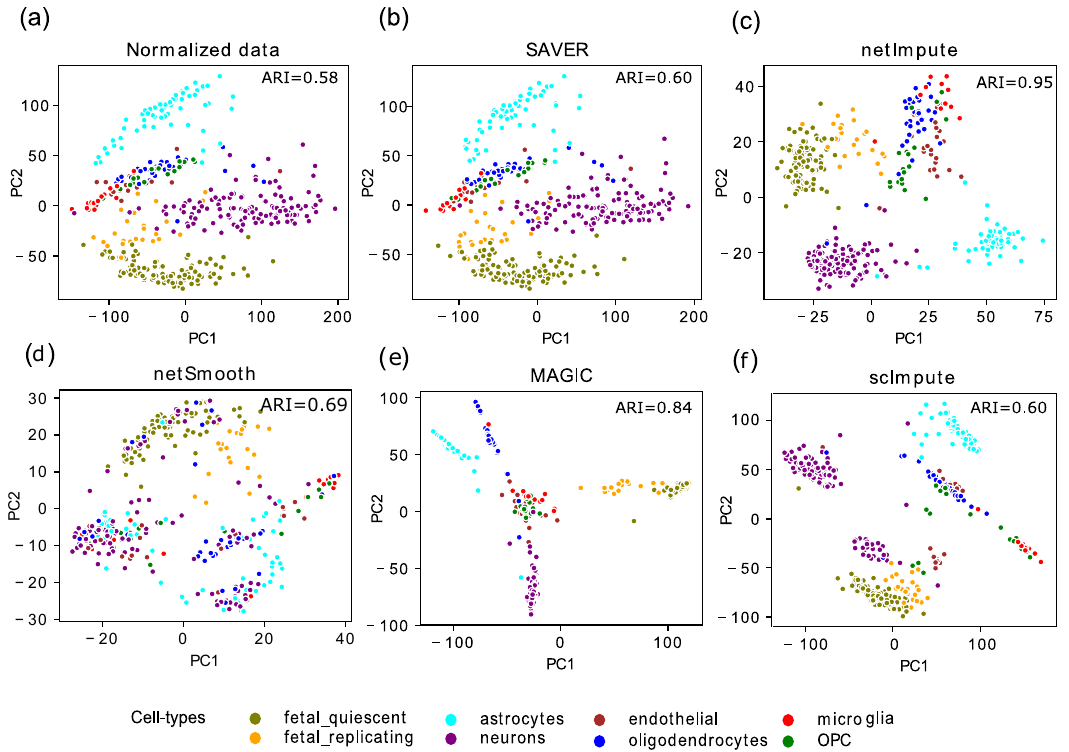
Figure 4. (Color online) Cell clustering and 2D PCA plot of human brain dataset. ( a ) no imputation; ( b ) after application of SAVER; ( c ) after application of netImpute; ( d ) after application of netSmooth; ( e ) after imputing with MAGIC; ( f ) after application of scImpute.